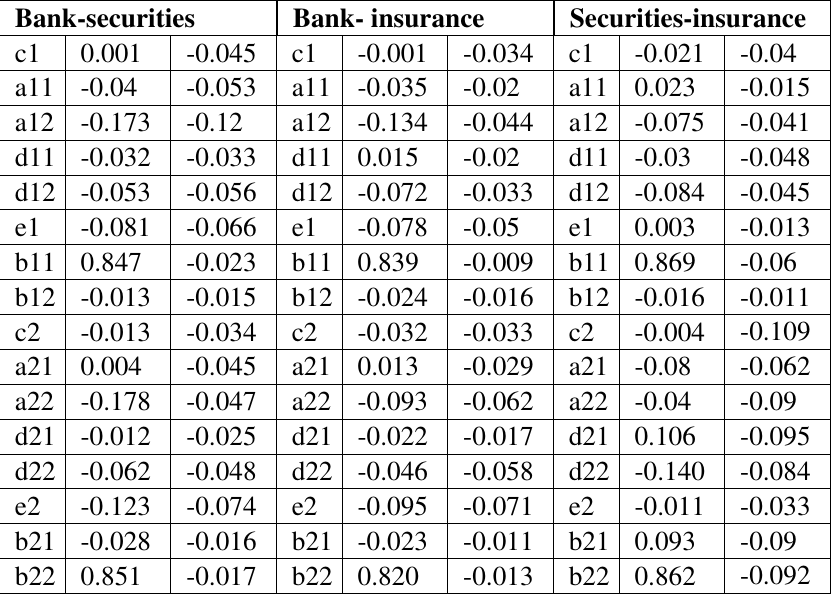
Fig. 1 The impulse response process of the banking and securities market shocks. Table 4 The estimation results of the joint asymmetric MVMQ-CAViaR model